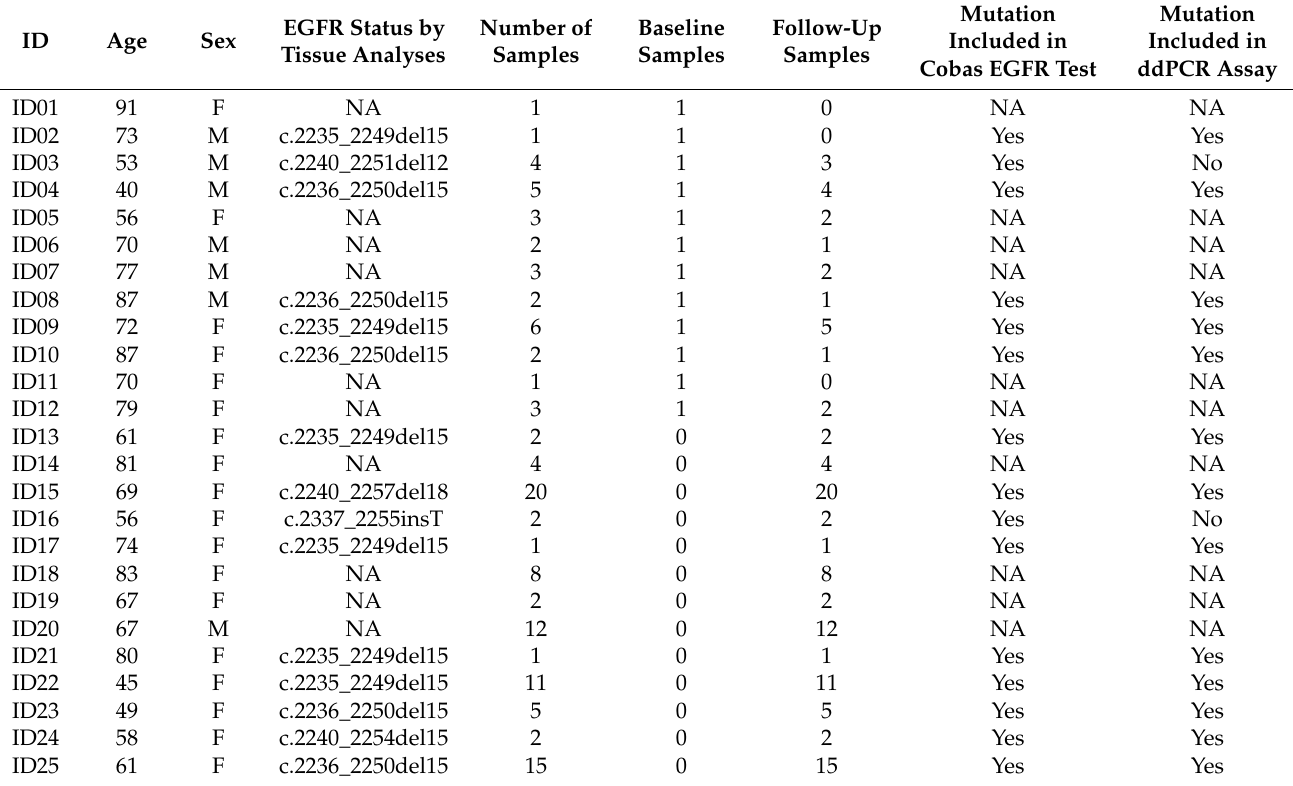
Table 1. Characteristics of lung cancer